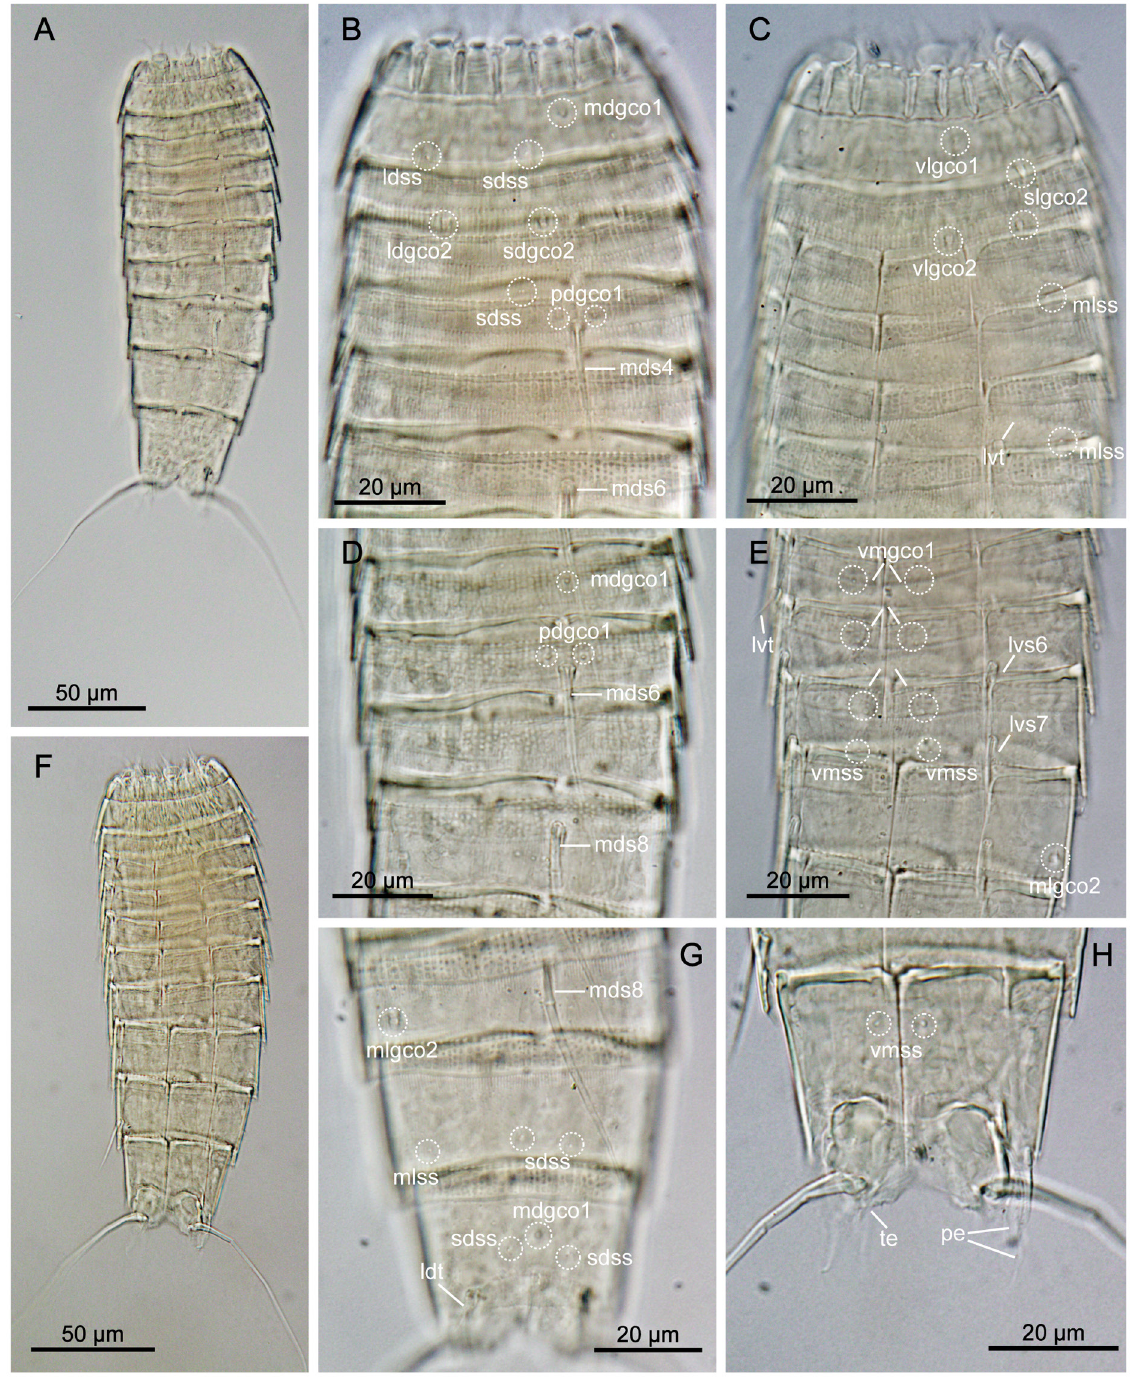
Fig. 24. Light micrographs showing overview and details of Echinoderes legolasi sp. nov., ♂, holotype (NIWA-159422). A . Dorsal overview. B . Segments 1 to 6, dorsal view. C . Segments 1 to 6, ventral view. D . Segments 5 to 8, dorsal view. E . Segments 5 to 8, ventral view. F . Ventral overview. G . Segments 8 to 11, dorsal view. H . Segments 10 to 11, ventral view. Abbreviations: see Material and